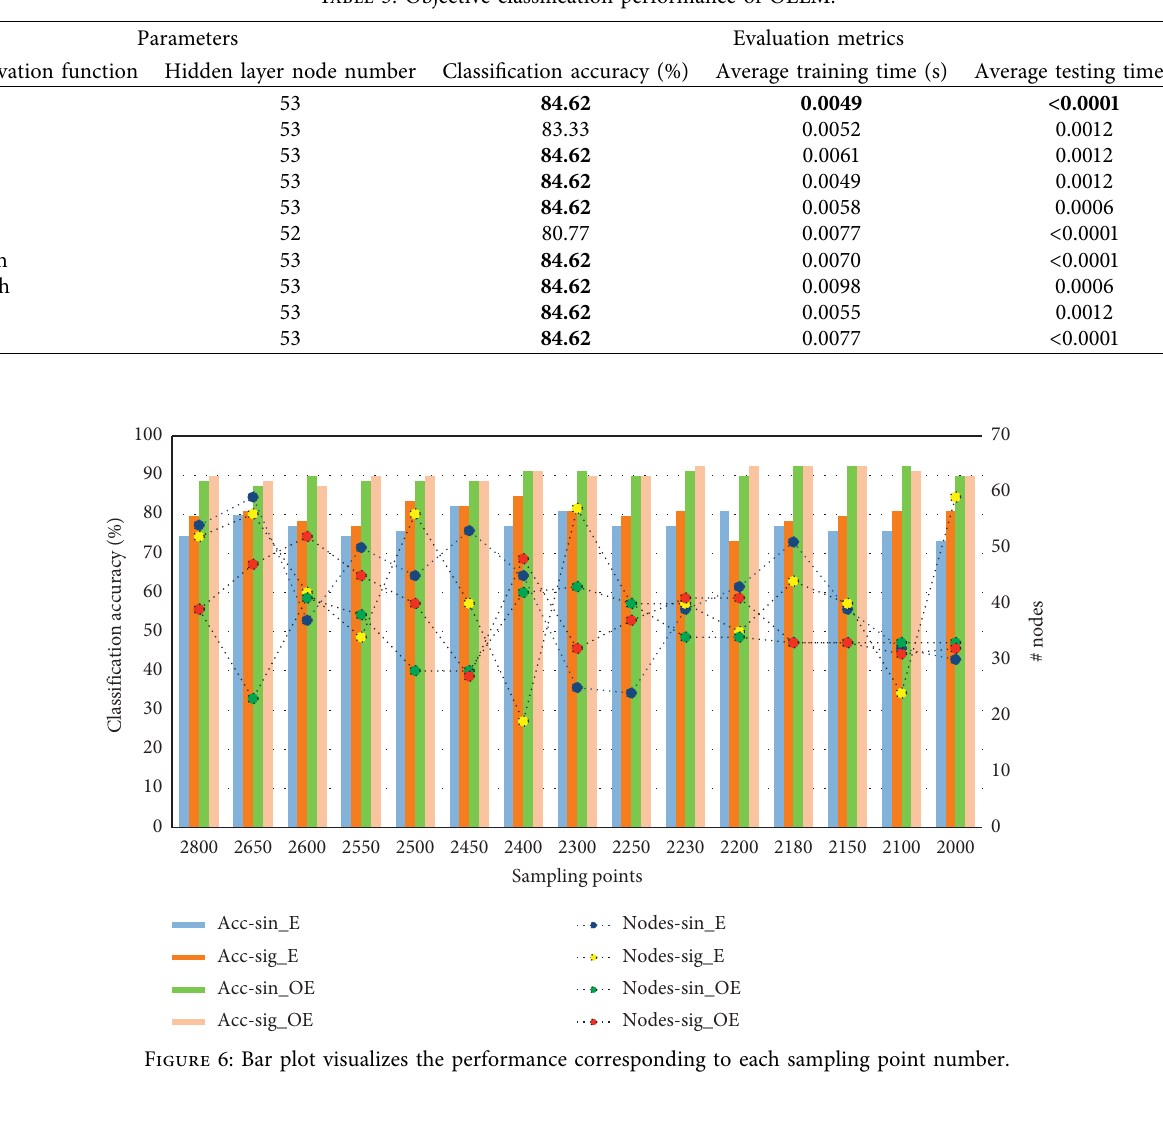
Table 3: Objective classification performance of